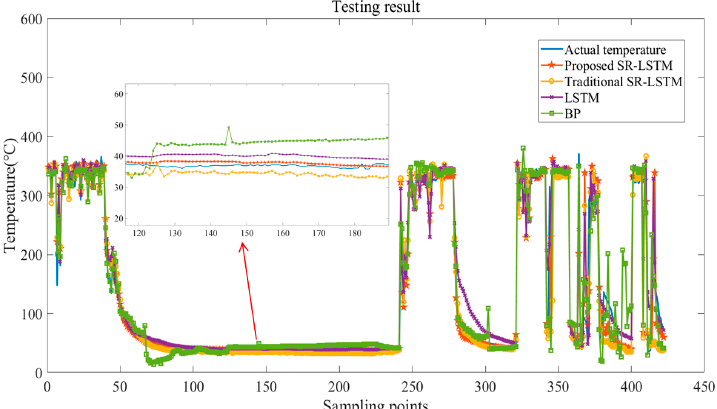
Figure 10. Comparison of prediction results.